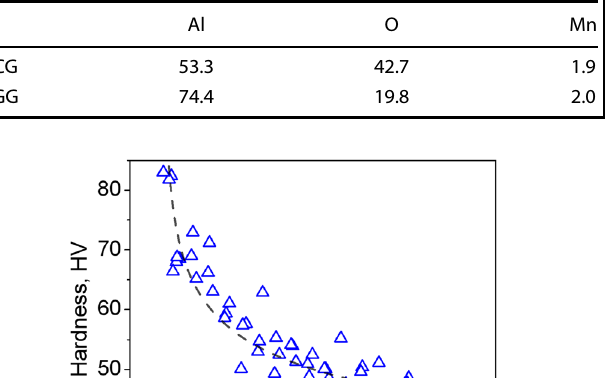
Table 1. XPS chemical compositions (wt%) of the topmost surface of CG and GG samples.